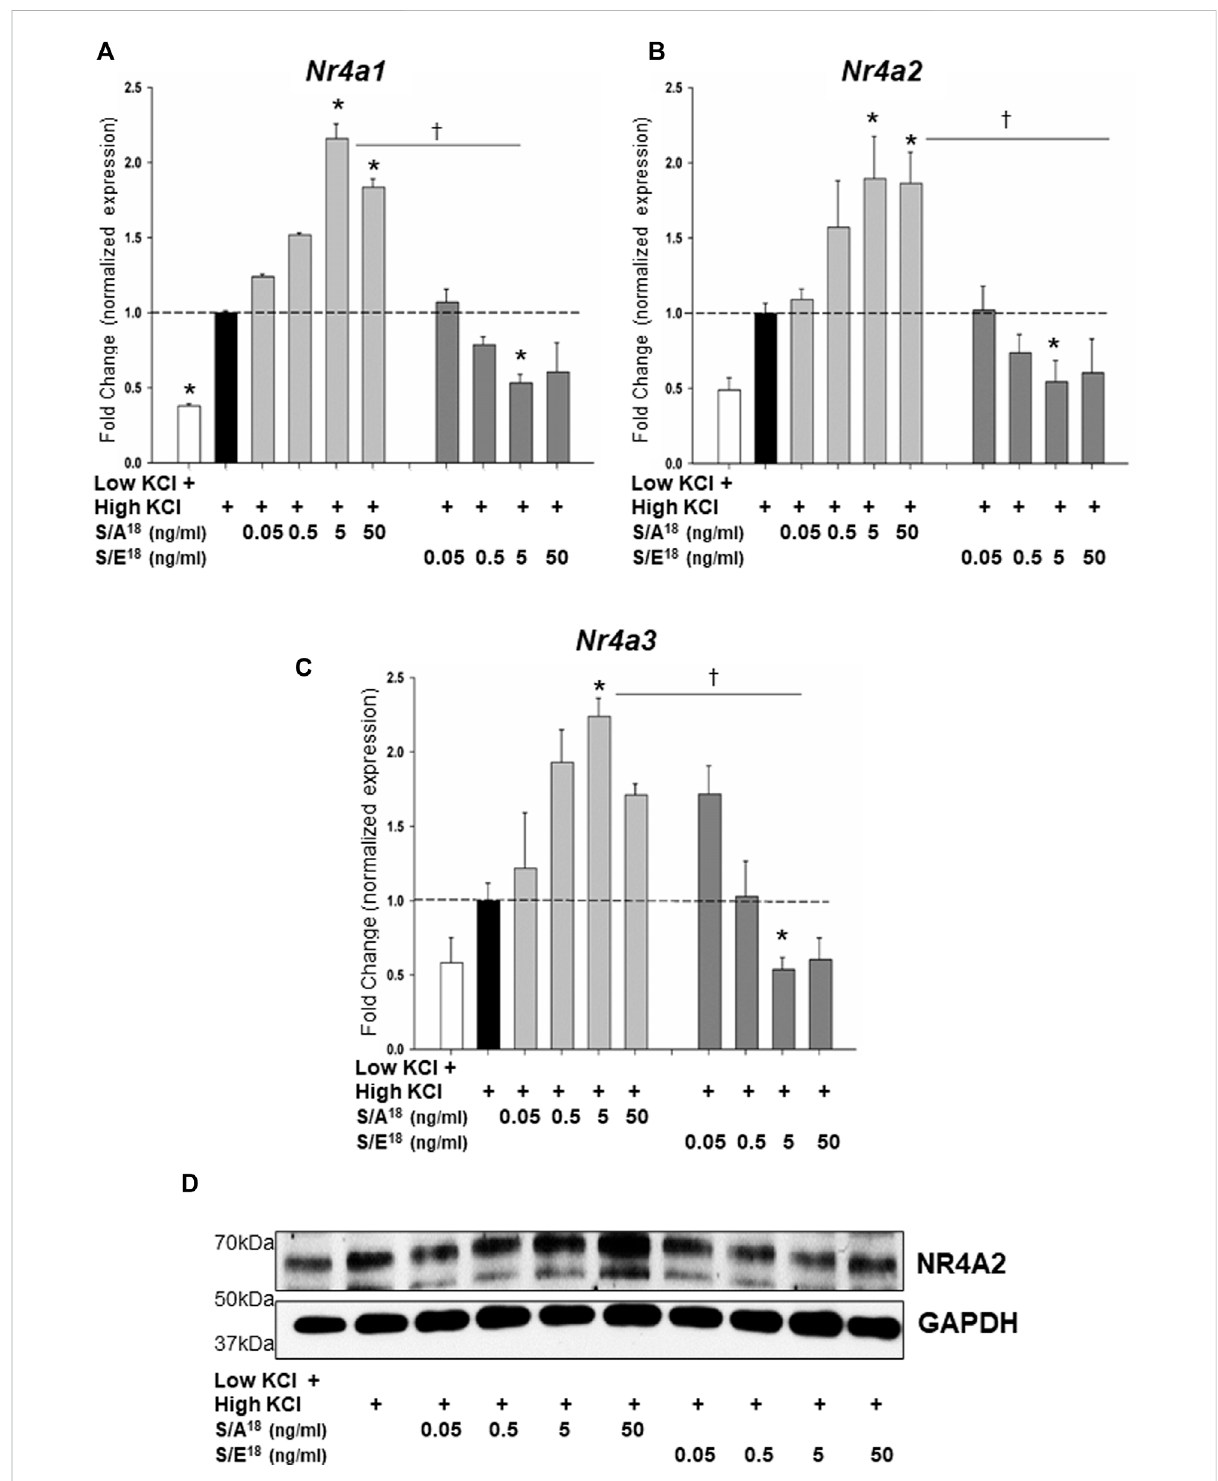
FIGURE 8 Modulation of NR4A subgroup ( Nr4a1,2,3 ) mRNA expression in C 2 C 12 myotubes in response to peptide treatments following membrane depolarization. Membrane depolarization was induced by incubating cell in Krebs-Ringer buffer containing 84 mM KCl and 3 mM CaCl 2 (High KCl) followed by peptide treatments. (A,B,C) . Nr4a1 , Nr4A2 and Nr4a3 mRNA expression at 1 h (* p < 0.05 vs CTL in high KCl alone, † p < 0.05 vs peptide at thesame dose, n=3independentexperiments). (D) . NR4A2proteinexpressionin C 2 C 12 myotubes in response to peptide treatments following membrane depolarization at 1